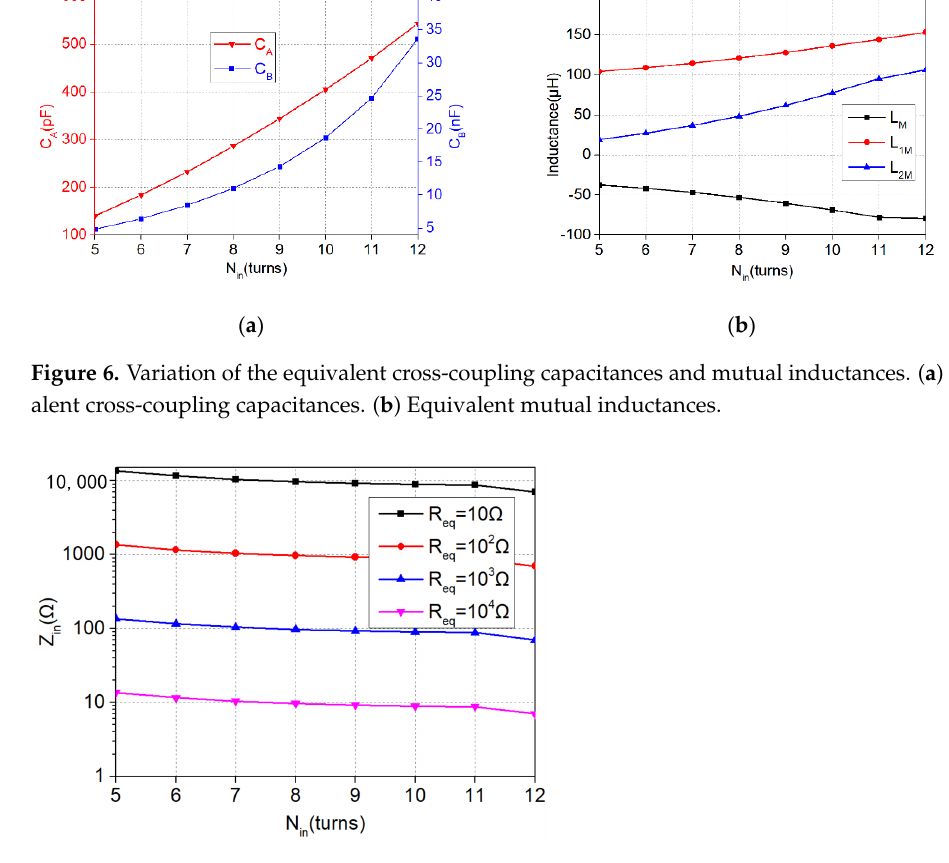
Figure 7. Variation of the input impedance.